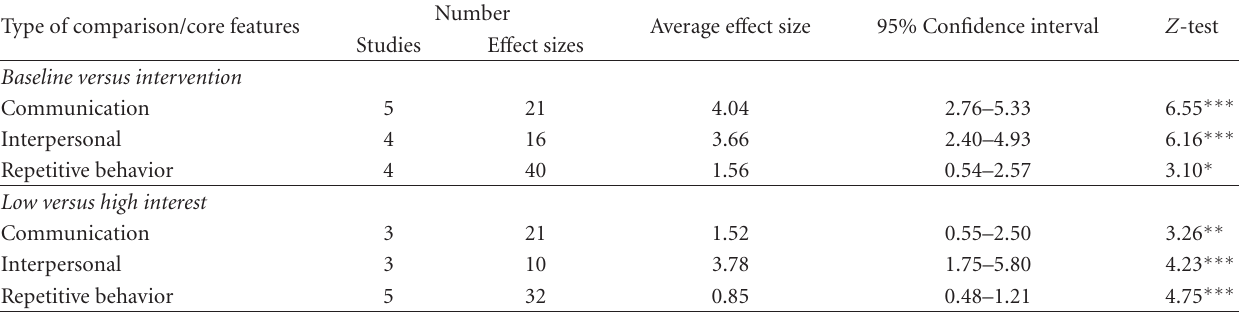
Table 1: Average e ff ect sizes and 95% confidence intervals for interventions targeting di ff erent core features of autism spectrum